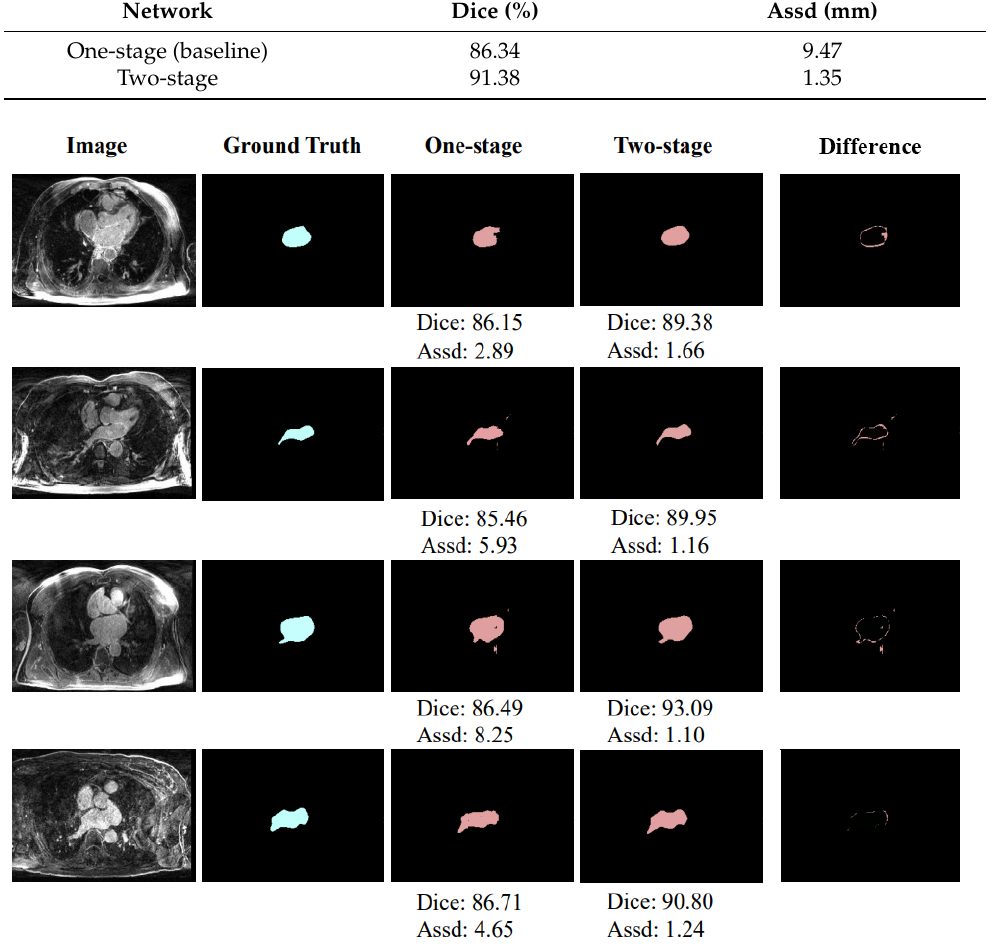
Figure 4. Exemplar segmentation results of the one-stage network and two-stage